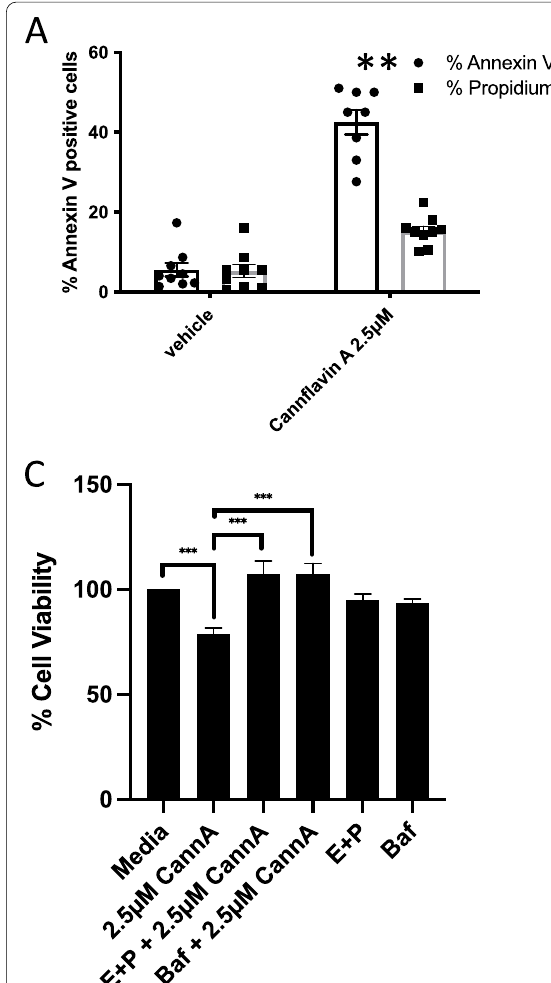
Fig. 3 Effects of cannflavin A on apoptosis and autophagy. Cells were treated for 24 h for apoptosis or 6h for autophagy with either the methanol vehicle or cannflavin A. A Histogram showing the percentage of annexin V–labeled cells and % cells stained for propidium iodide, indicative of apoptosis. Cells were counted from three random fields of view on a fluorescence microscope. ** p < 0.01, n of at least 8. B Western blotting analysis was performed using an anti-caspase 3 antibody, and β-tubulin was included as a loading control. The results indicate activation of caspase 3. Figure is a representative blot of n 3 experiments. C Histogram showing the percentage of cell viability following 24-h cannflavin A treatment in = T24 cells in the presence or absence of autophagy inhibitors (100 nM bafilomycin A or the combination of 10 μg/ml E-64d (aloxistatin) and 10 μg/ ml (pepstatin A)). The inhibitors were able to revert the cytotoxic effects of cannflavin A. *** p <0.001, n of at least